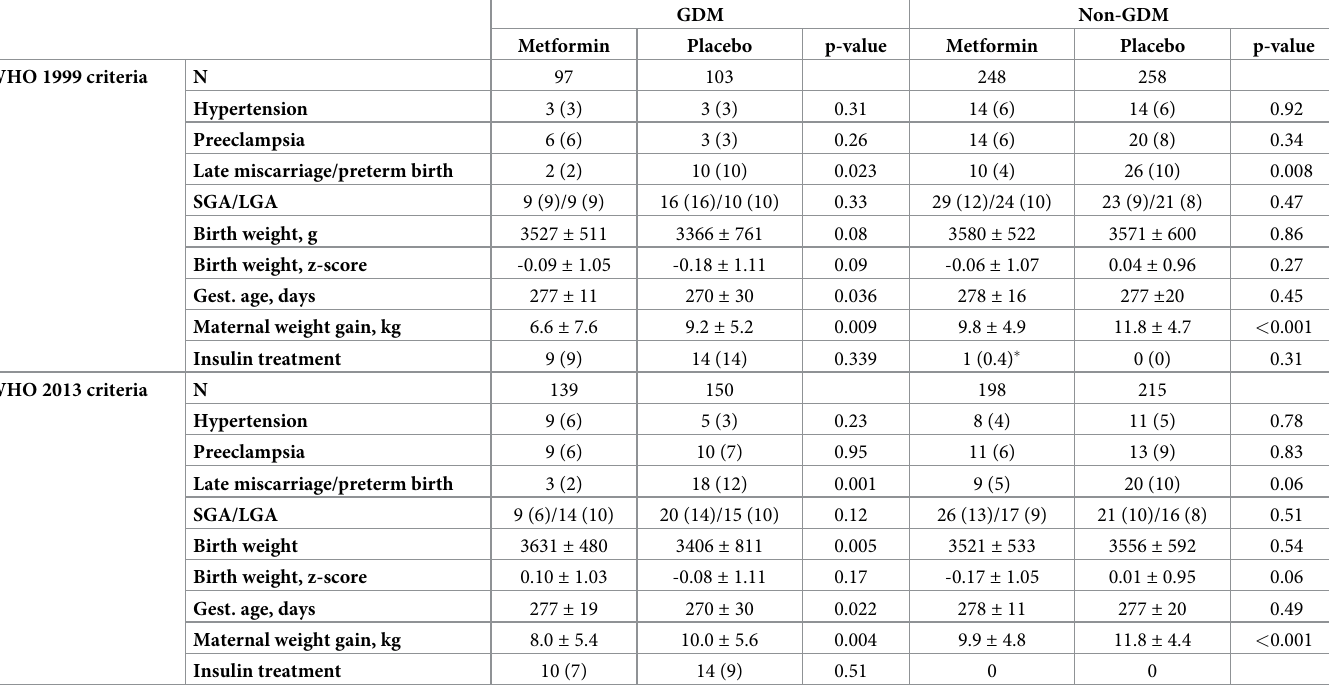
Table 5. Pregnancy complications in patients treated with metformin and placebo, women with and without